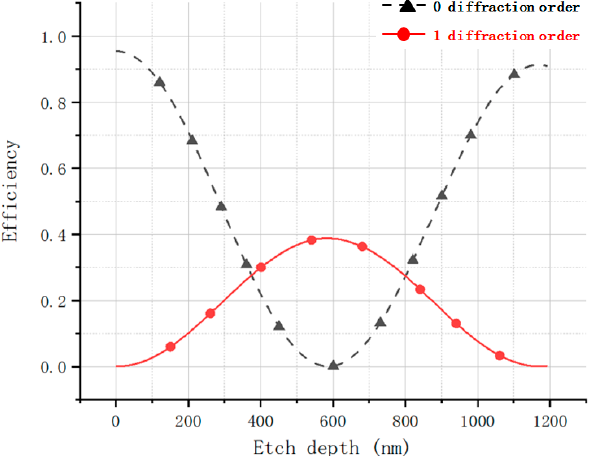
Figure 7. Diffraction efficiency variation curve with etching depth for 0 and ±1 diffraction levels of aberrated Fresnel zone plate (red represents level 0, black represents level ±1).